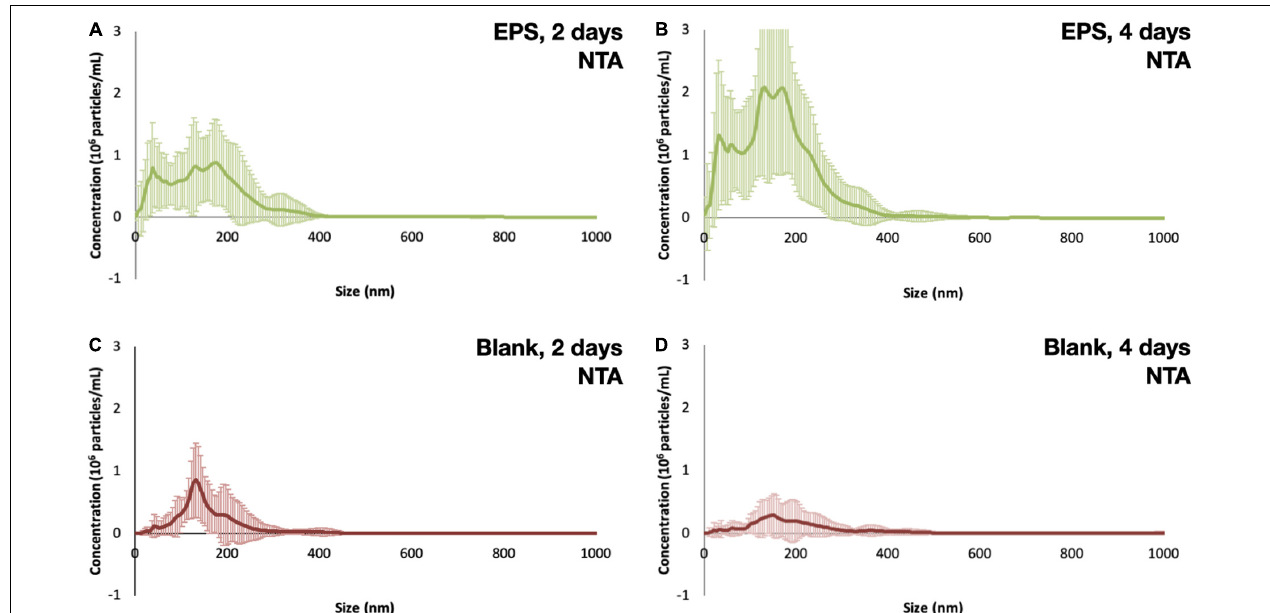
FIGURE 6 | Size distribution of particles measured with NTA after (A) 2 days of fragmentation, (B) 4 days of fragmentation, (C) blank samples after 2 days of fragmentation, and (D) blank samples after 4 days of fragmentation.